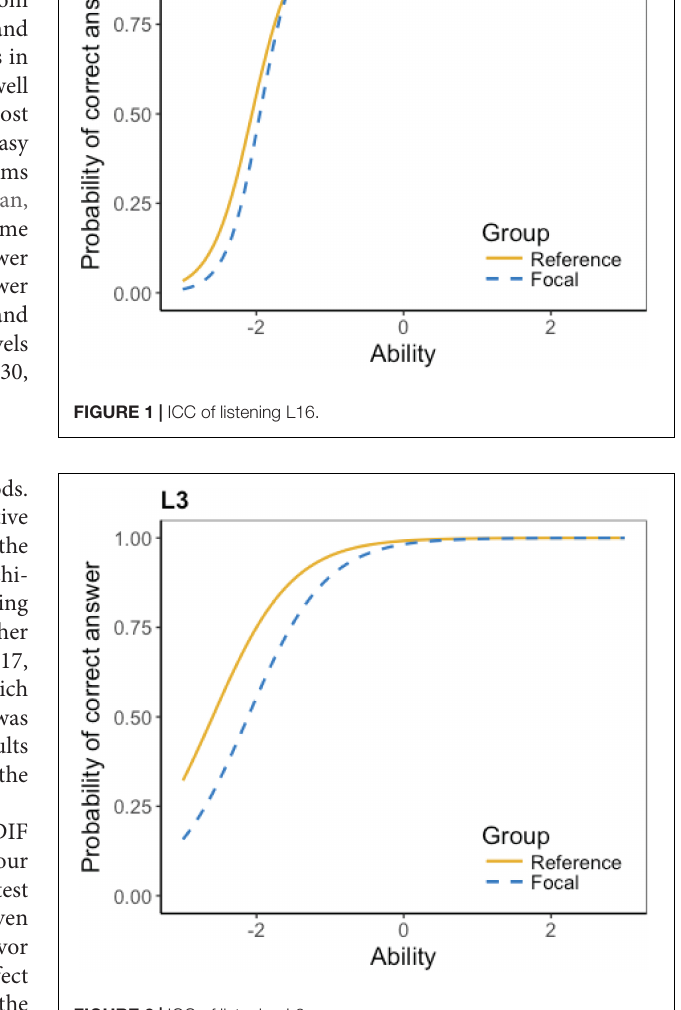
FIGURE 2 | ICC of listening